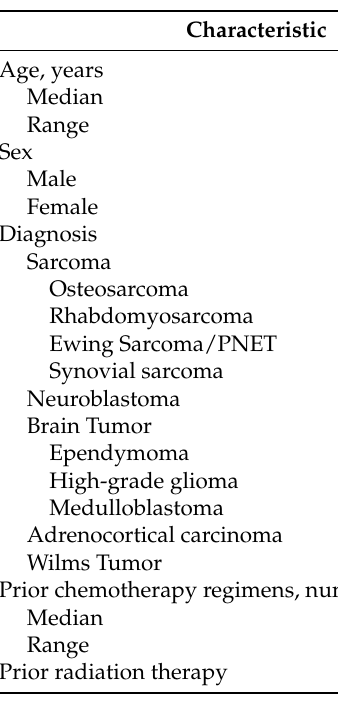
Table 1. Characteristics of eligible patients.